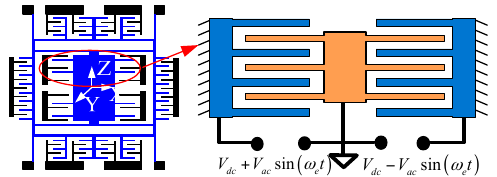
Figure 1. Schematic view of an electrostatic comb structure.